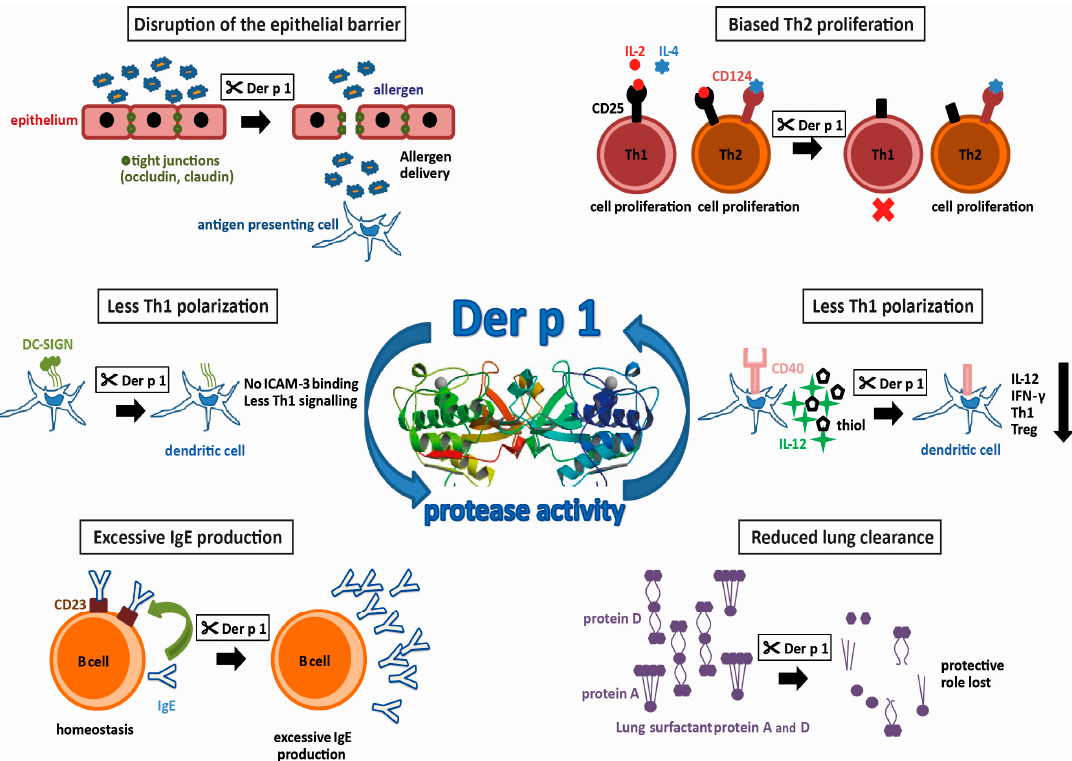
Figure 1. Protease activities possibly promoting allergenicity of Der p 1 (allergen 3D structure, 2AS8 structure [30]).